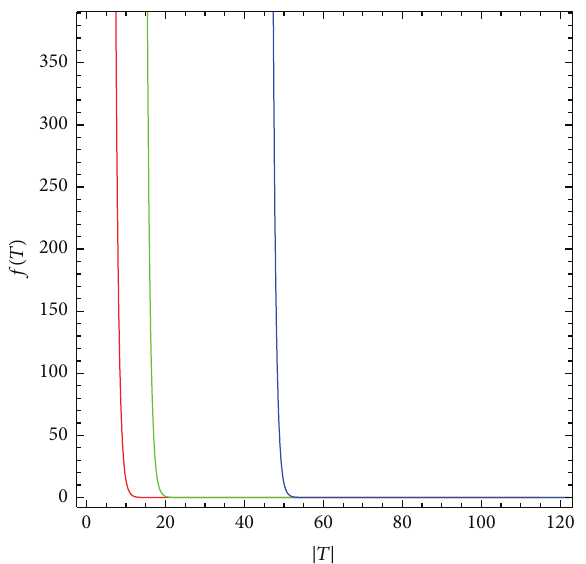
Figure 13: Deceleration parameter using (63) in (37).